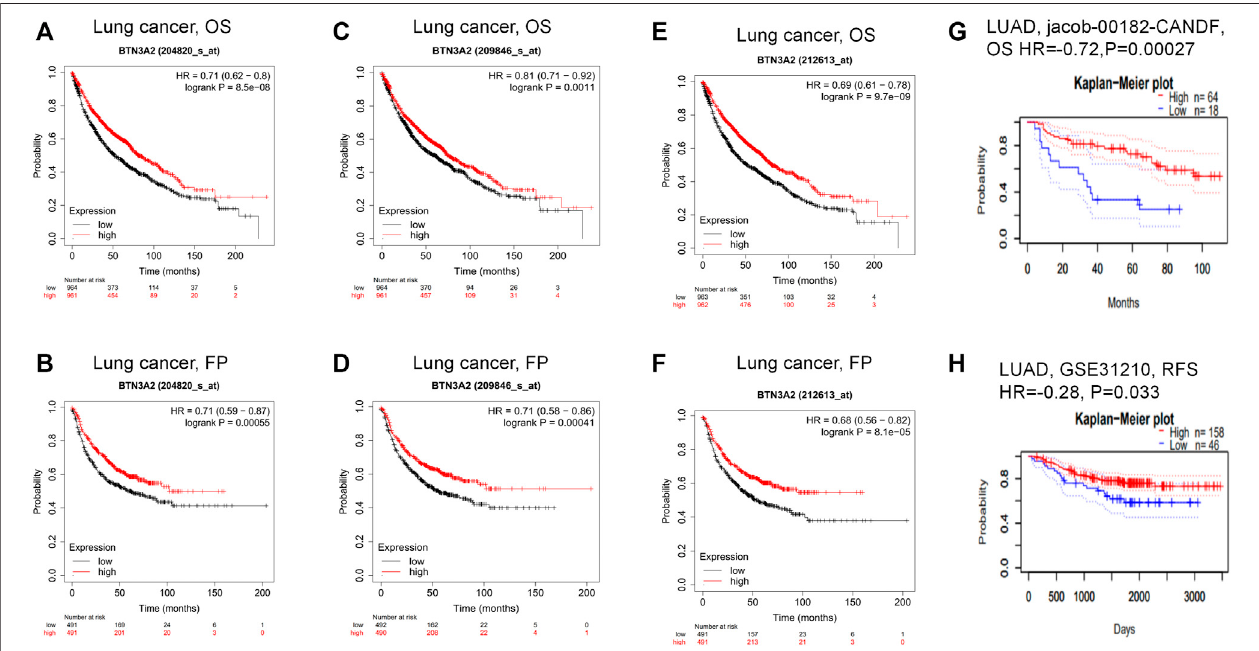
FIGURE 3 | Comparing the high and low expression of BTN3A2 in LUAD by Kaplan – Meier survival curves. (A – B) OS and FP survival curves of lung cancer in 204820_s_at probe ( n = 1295, n = 982). (C – D) OS and FP survival curves oflung cancer in 209846_s_at probe. ( n = 1295, n = 982). (E – F) FP and OS survival curvesof lung cancer in 212613_s_at probe ( n = 1295, n = 982). (G – H) OS and RFS survival curves of LUAD in jacob-00182-CANDF and GSE31210, respectively. OS, overall survival; FP, fi rst progression; RFS, relapse free survival.